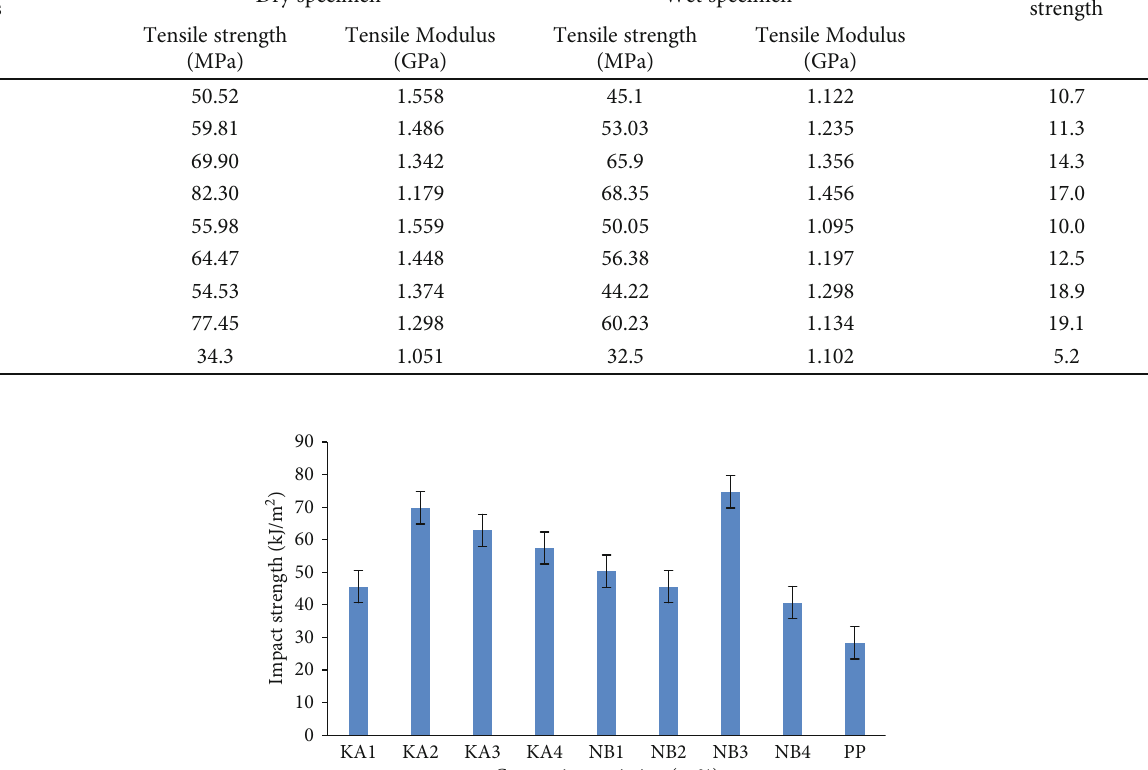
Table 3: Comparison of tensile strength and modulus of elasticity of polypropylene composites under wet and dry conditions.